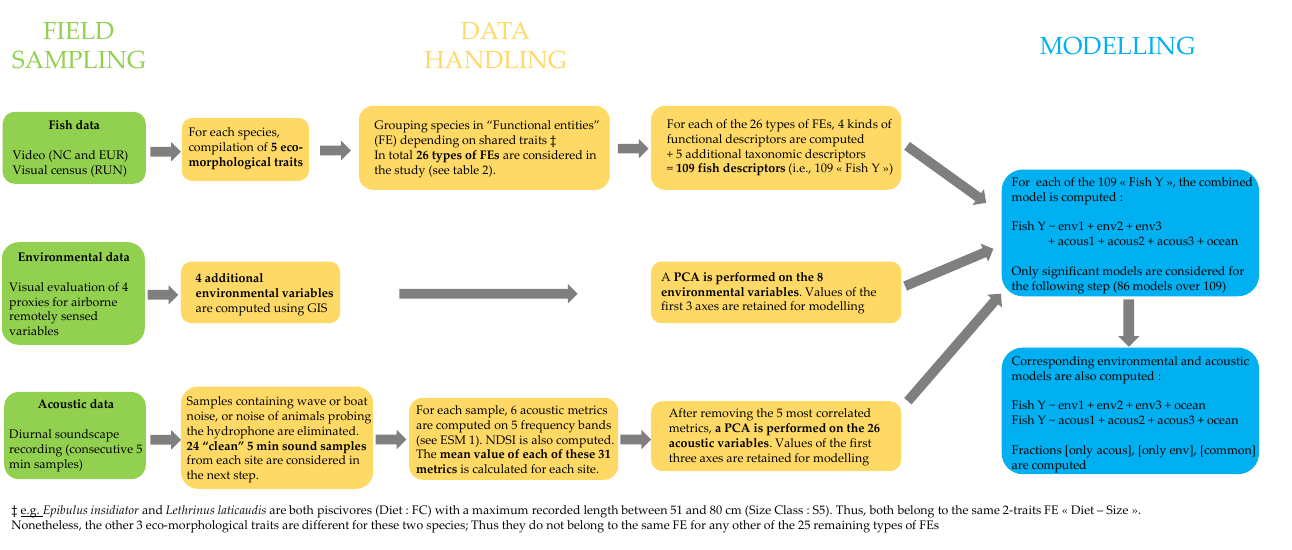
Figure 3. Flowchart summarising the methodological approach from sampling to data analysis (see Table 2).